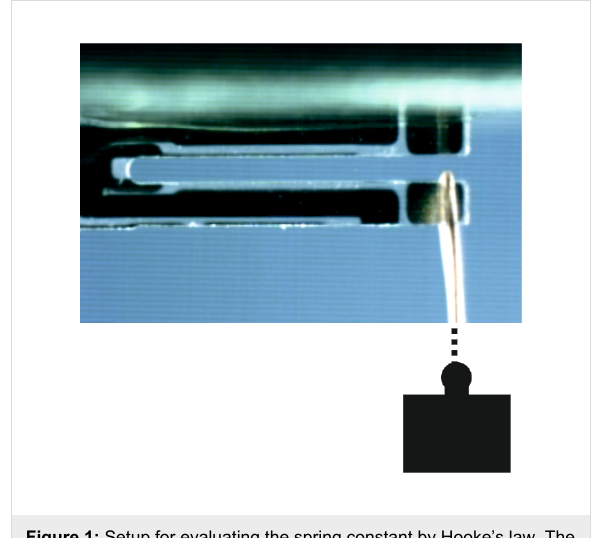
Figure 1: Setup for evaluating the spring constant by Hooke’s law. The deflection is measured by analyzing differences between images of the loaded and unloaded TF using WSxM